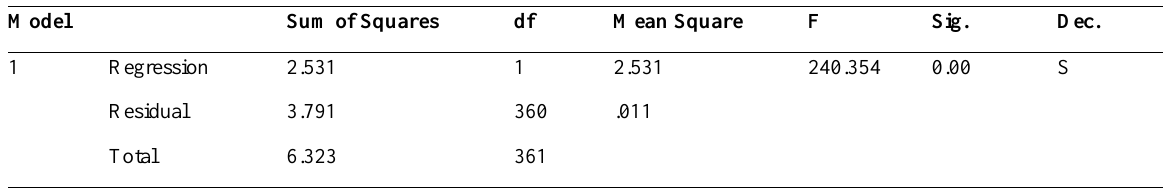
Table 4: Regression Analysis of the significant relationship between work stress and job satisfaction among early childhood educators in Cross River State, Nigeria Model